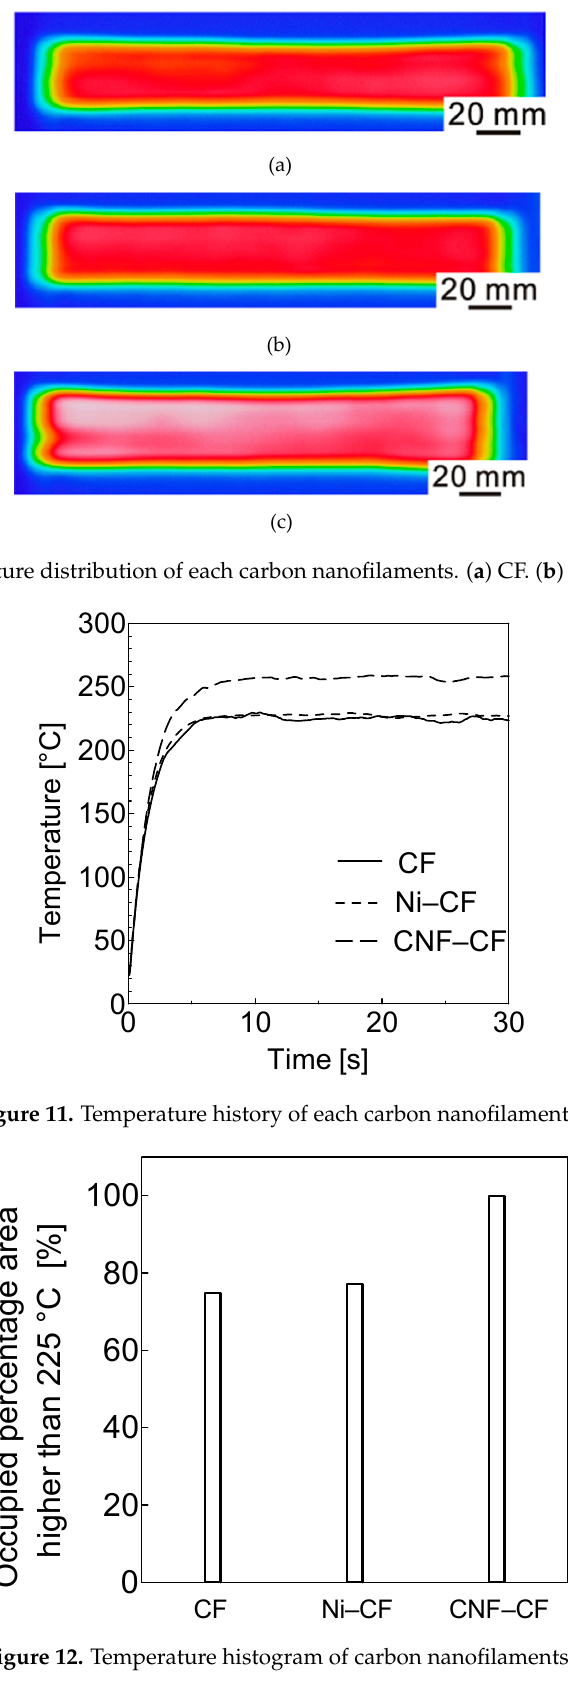
Figure 12. Temperature histogram of carbon nanofilaments.